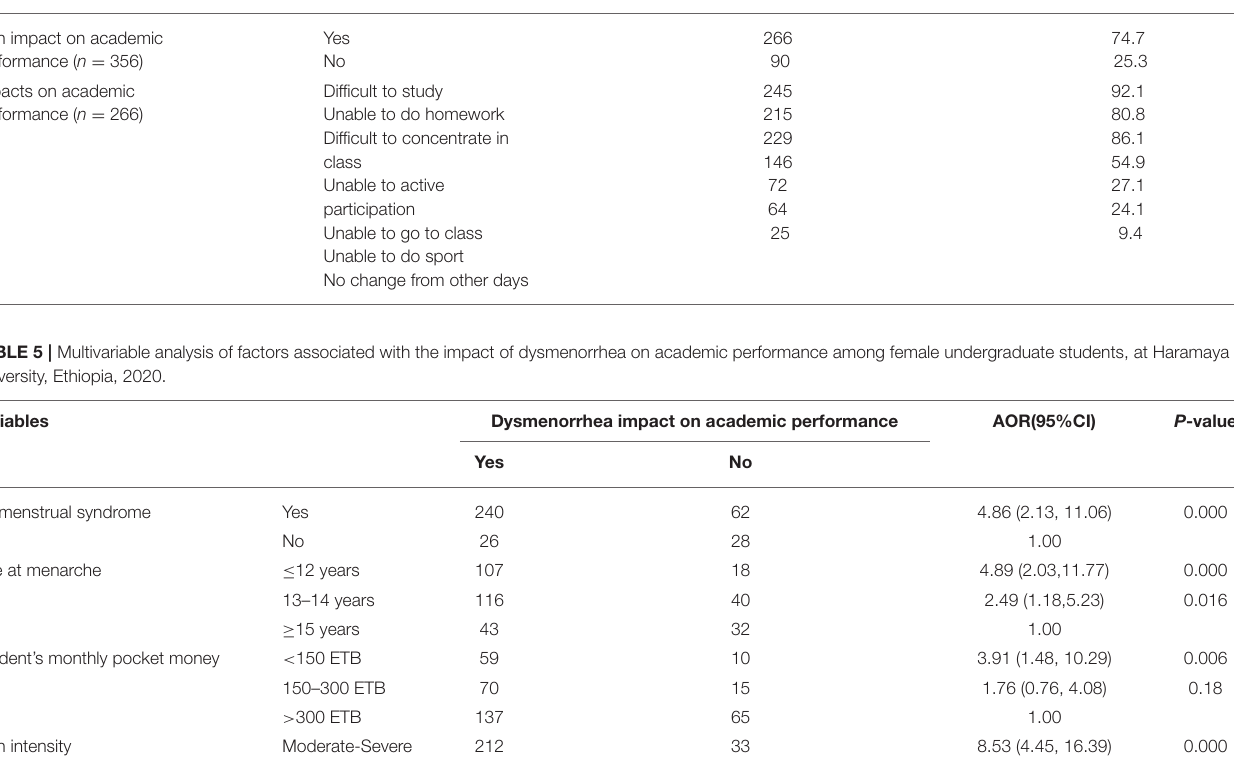
TABLE 4 | Prevalence of impact of dysmenorrhea on academic performance of female undergraduate students, at Haramaya University, Ethiopia, 2020. Characteristics